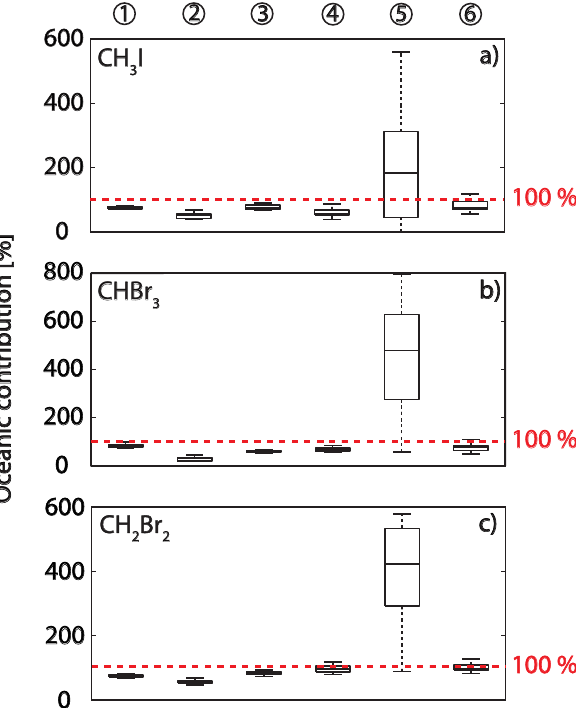
Fig. 9. Sea-to-air fluxes for CH 3 I (a) , CHBr 3 (b) and CH 2 Br 2 (c) during DRIVE and the MABL height, determined by Fuhlbrügge et al. (2013) as the dashed grey line are shown on the right side. The upper and lower value of potential sea-to-air fluxes assuming the lowest MABL (lower range, 3.0ppt for CH 3 I, 3.1ppt for CH 2 Br 2 and 8.9ppt for CHBr 3 ) and the highest MABL (upper range, 0.6ppt for CH 3 I, 0.9ppt for CH 2 Br 2 and 0.5ppt for CHBr 3 ) valid for the whole region are shaded in green.